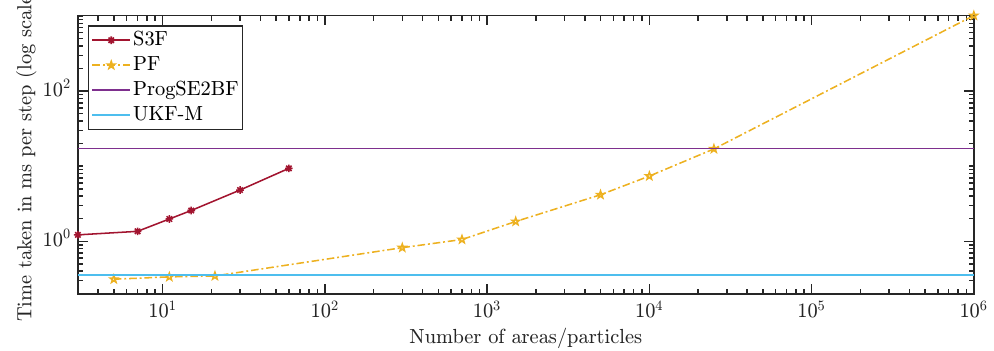
Figure 12. Run time over number of areas or particles. For a fair comparison of the filters, which have very different run times, we compare the errors over the run times in Figures 13 and 14. A configuration to the lower left of another is strictly better because more accurate results were achieved using less run time. Configurations to the upper left were faster but provided less accurate results. Ones to the lower right were slower but better in terms of accuracy. The latter two cases do not allow for a clear ranking. The plots can be used to assess which filters should be considered given certain run time constraints. However, they can only serve as a rough guideline since the run times highly depend on the scenario, implementation, and hardware.